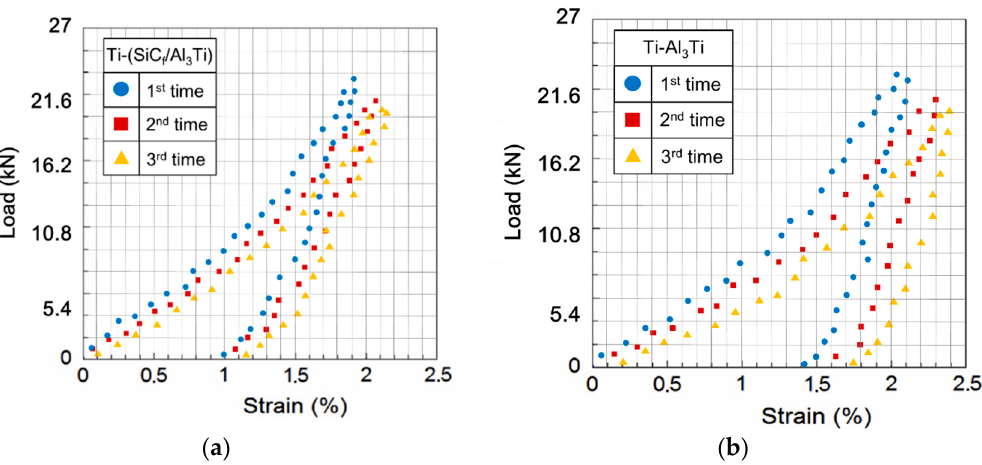
Figure 16. Original data of compressive load-strain curves solved with indentation test under spherical indenter: ( a ) Ti-(SiC f /Al 3 Ti) CCFR-MIL specimens and ( b ) Ti-Al 3 Ti MIL specimens.